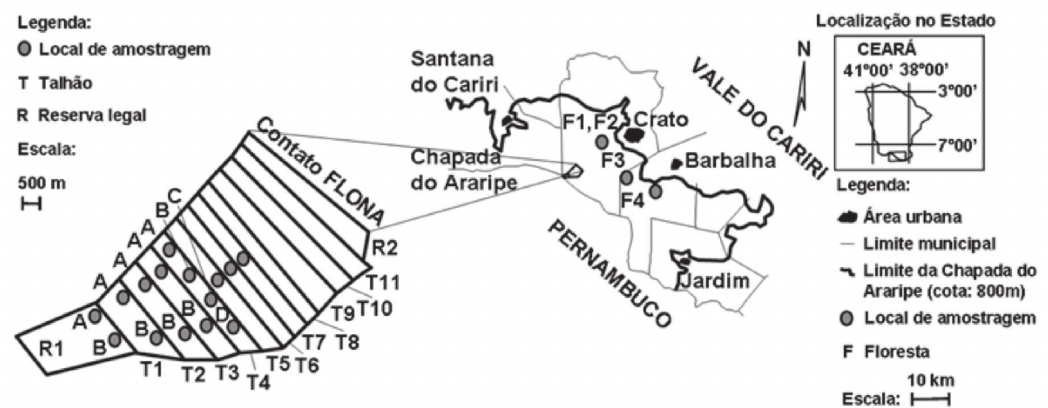
Figura 1. Locais de amostragens na Unidade de Manejo Florestal estudada (R e T) e na Floresta Nacional do Araripe